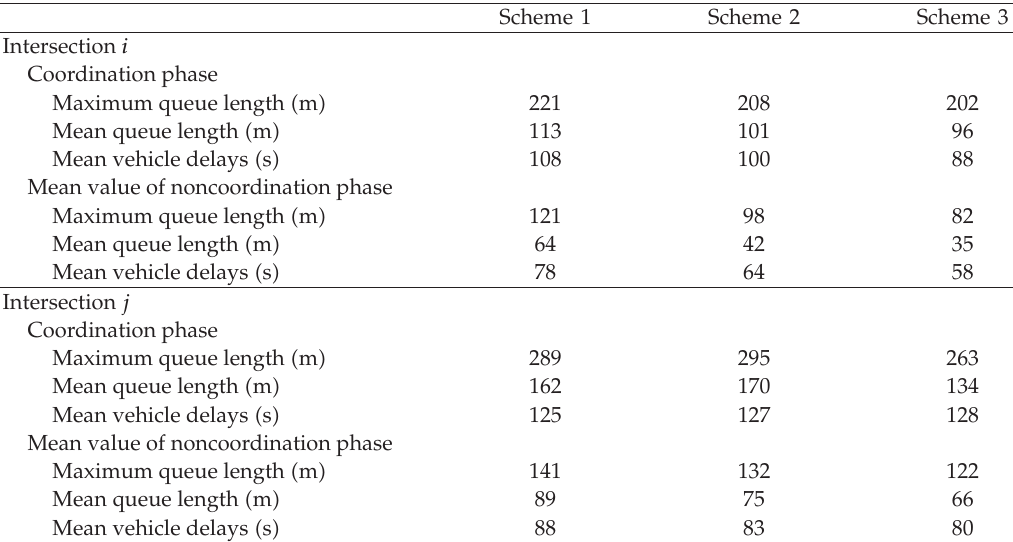
Table 3: Outputs parameters of the